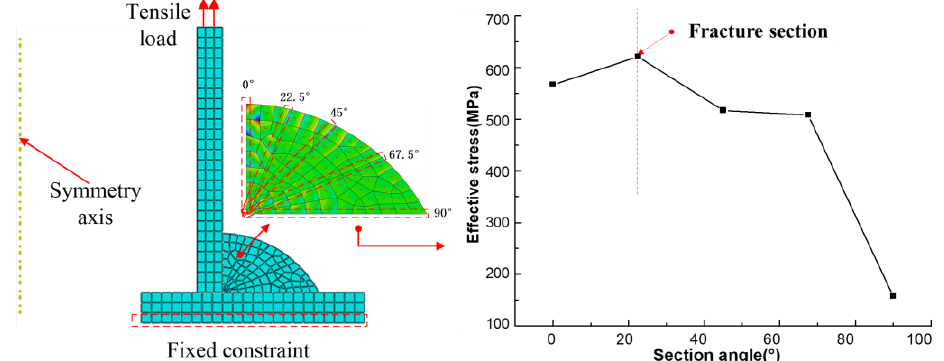
11 of 14 Figure 13. FEM and nodal force distribution of the U−shaped fillet welded specimen. The FE model of the pipe-plate fillet-welded specimen is shown in Figure 14. Accord-